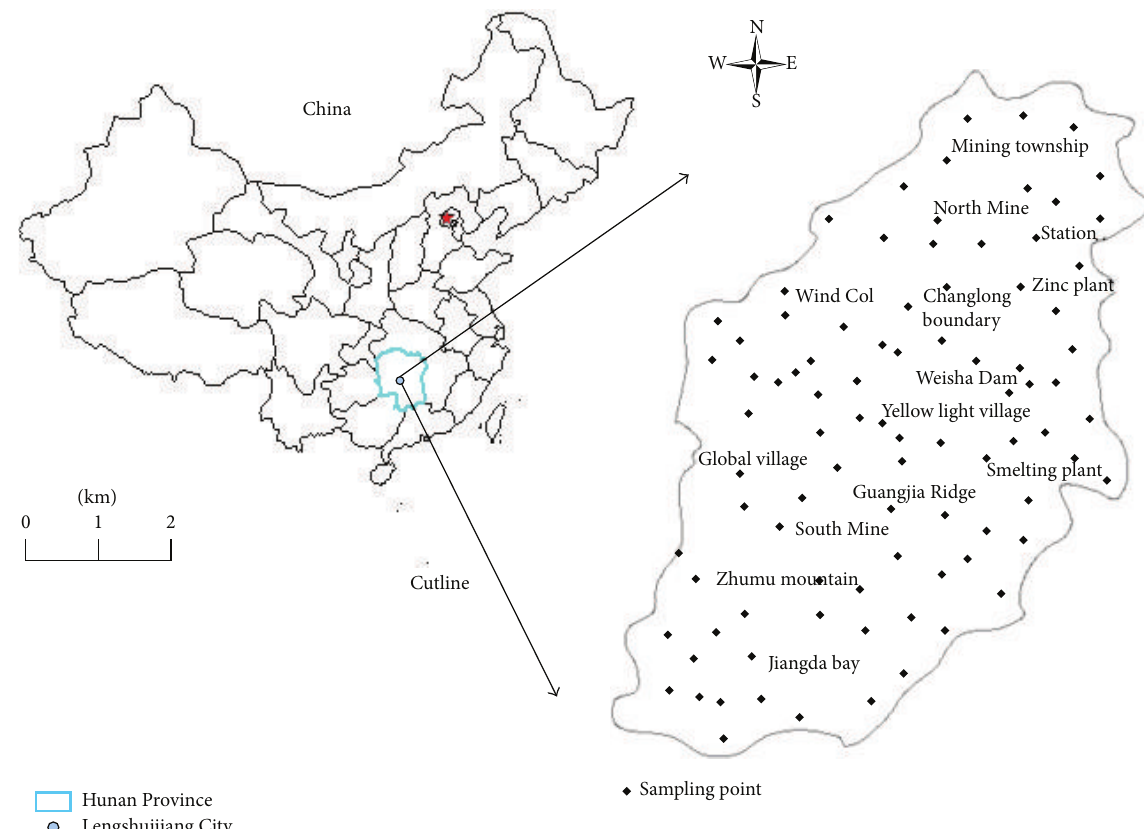
Figure 1: Sampling points